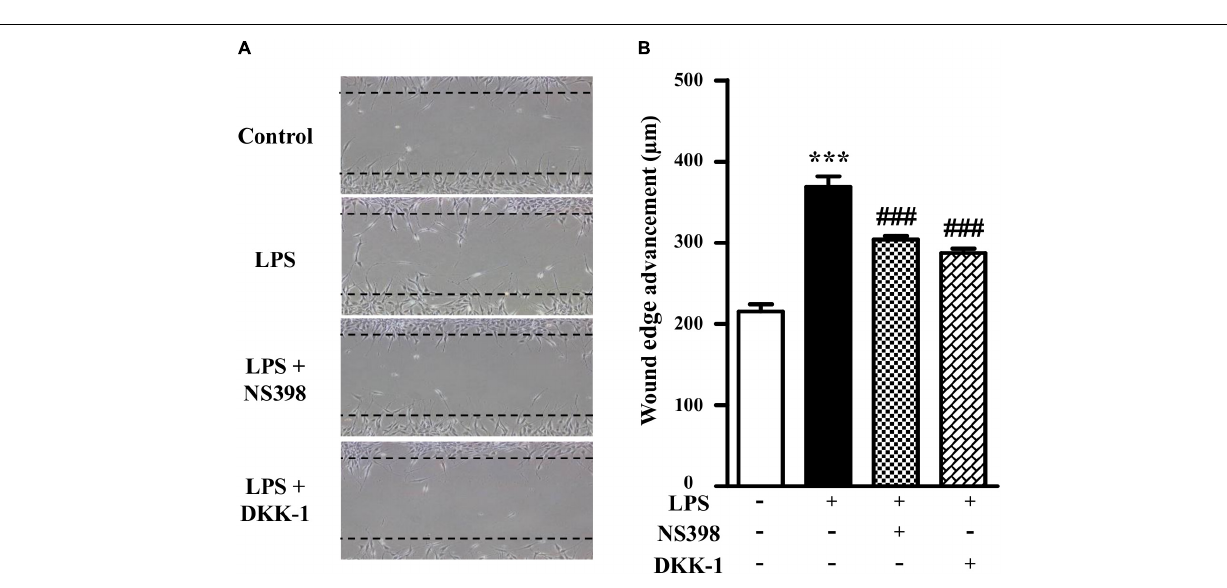
FIGURE 3 | β -Catenin interacted with COX-2 in the NIH3T3 cells treated with LPS. (A) Treatment of NIH3T3 cells with NS398 or DKK-1 for 24 h inhibited the cell migration potential. The wound edge advancement was counted by Image Pro Plus software. (B) Quantification of the scar widths. ∗ P < 0.05, ∗∗ P < 0.01, and ∗∗∗ P < 0.001 vs. control; # P < 0.05 and ### P < 0.001 vs. the LPS group, n =